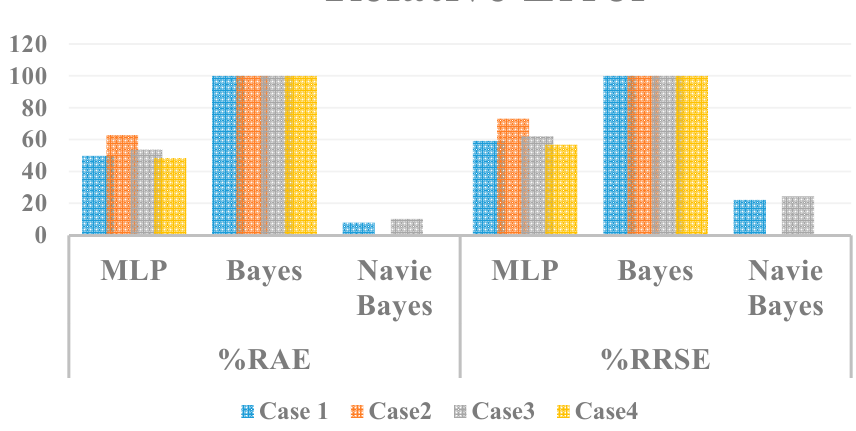
Figure 18. Percentage relative absolute error (% RAE) comparison of various classifiers. Table 10. Percentage root relative square error (% RRSE) comparison of various classifiers.